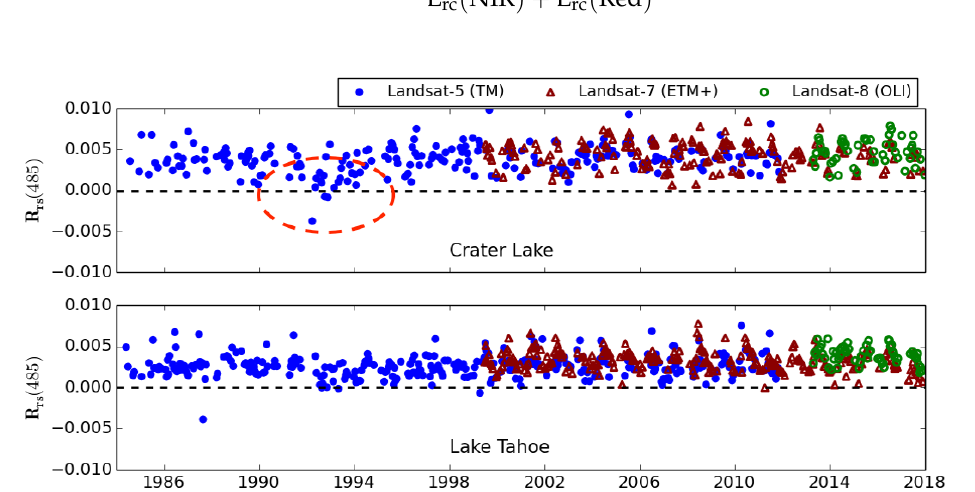
Figure 13. The time-series of R rs products in the blue bands over optically stable waters of Crater and Tahoe lakes. The overall signal level is very similar in time. A potential anomaly found for TM products is highlighted in the Crater Lake